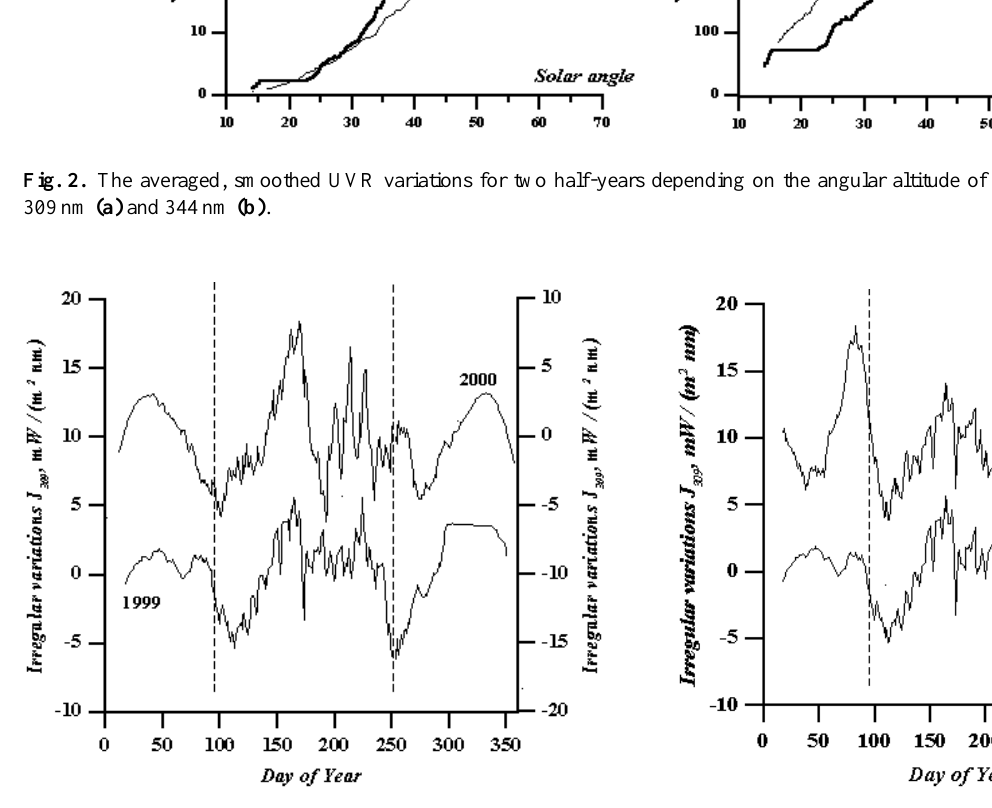
Fig. 4. The averaged irregular UVR variations upon removal of the annual trends for two wavelengths for